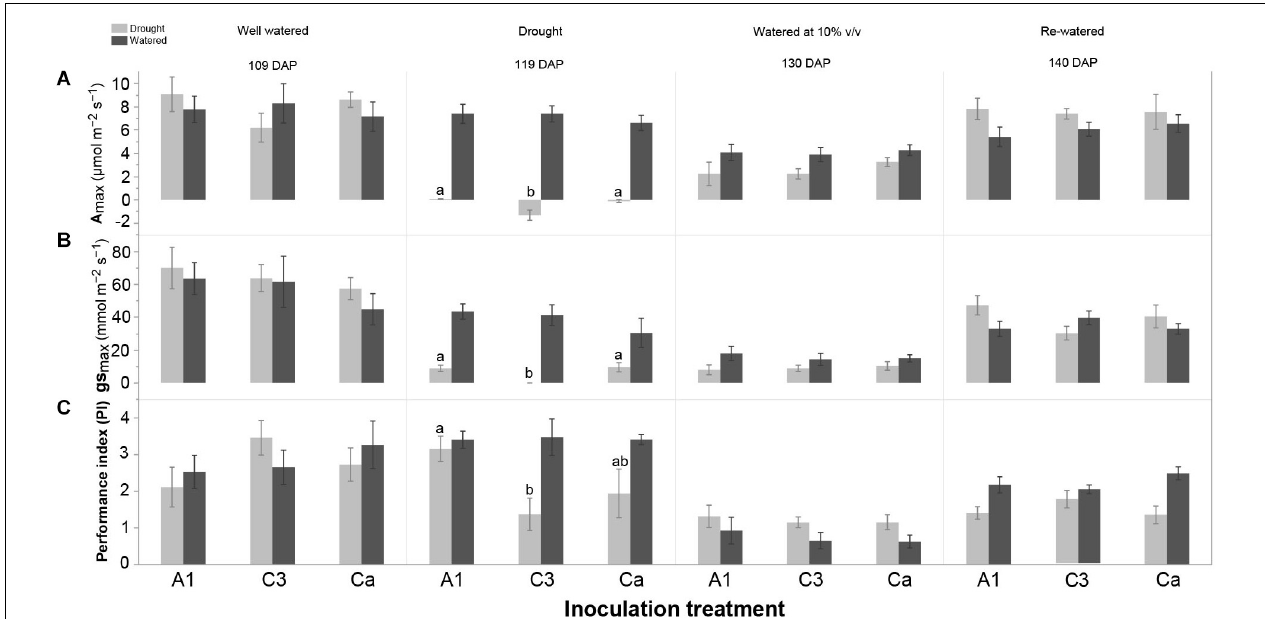
FIGURE 4 | Effect of inoculation with R. irregularis isolates A1 and C3 on (A) photosynthetic capacity (A max ), (B) stomatal conductance (g smax ) and (C) performance index (PI) of cassava in well-watered (watered) and water-stressed (drought) conditions at four sampling times: 109 DAP, 119 DAP, 130 DAP and 140 DAP in Experiment 2. Error bars represent ± S.E. Different letters above bars represent significant differences at p < 0.05 according to a Tukey post-hoc test. Comparison among inoculation treatments in either well-watered (watered) or water-stressed (drought) conditions at each sampling